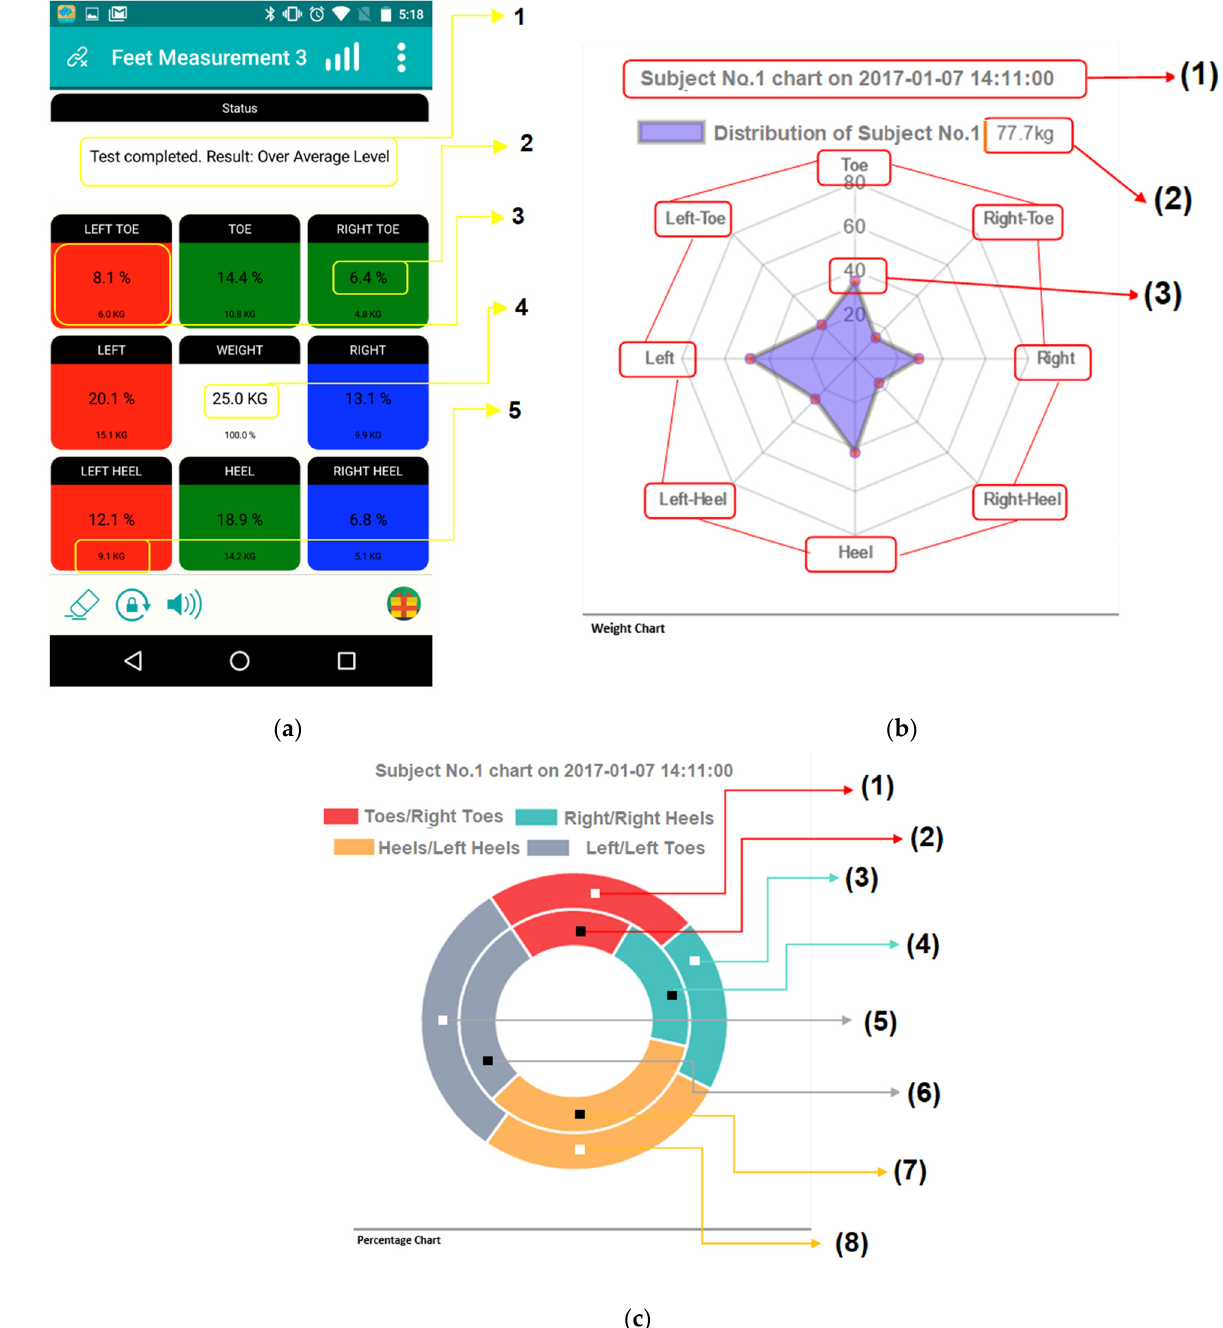
Figure 5. The software displays for ( a ) the mobile App-based display, indicating an unbalanced distribution of bodyweight loads right-left and front-back; ( b ) the website display in weight chart; and ( c ) the percentage chart for various sections (1) Right and (2) Right Toes, (5) Left and (6) Left Toes, (3) Right and (4) Right Heel, and (7) Left Heel and (8) Heel.